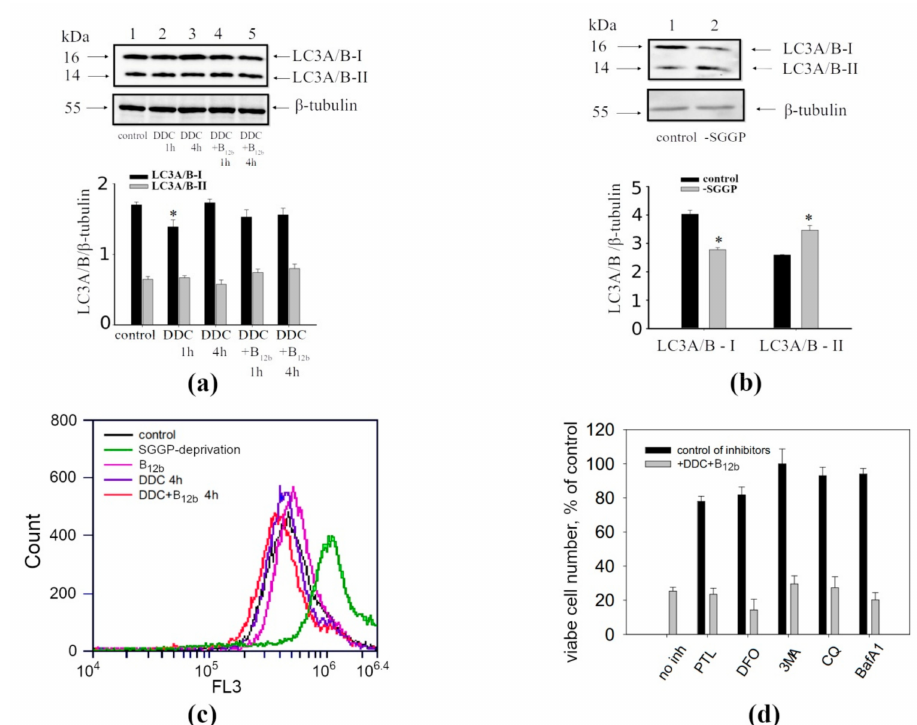
Figure 6. Absence of the signs of autophagy and the involvement of lysosomes in the induction of death of HEp-2 cells by the combination 1 mM DDC + 25 µ M B 12b . ( a ) Immunoblot analysis of autophagy markers in HEp-2 cells after the 1-h and 4-h incubation with DDC (1 mM) or DDC + B 12b ; ( b ) immunoblot analysis of autophagy markers in HEp-2 cells after the 4-h incubation in SGGP-deprived medium; ( c ) FL3 fluorescence of HEp-2 cells loaded with AO in untreated cultures, after 4-h starvation in SGGP-free medium, after 4-h incubation with DDC, B 12b , and DDC + B 12b ; ( d ) The chelators of intracellular iron ions and autophagy inhibitors did not protect cells during the 6-h incubation with DDC + B 12b . Cells were incubated in growth medium for 90 min with inhibitors or chelators, then DDC + B 12b was added, and after 6-h incubation, medium was replaced by a fresh growth medium without additives. The cytotoxic e ff ect was estimated 48 h after the treatment. *, di ff erences between the samples and the control are significant, p <